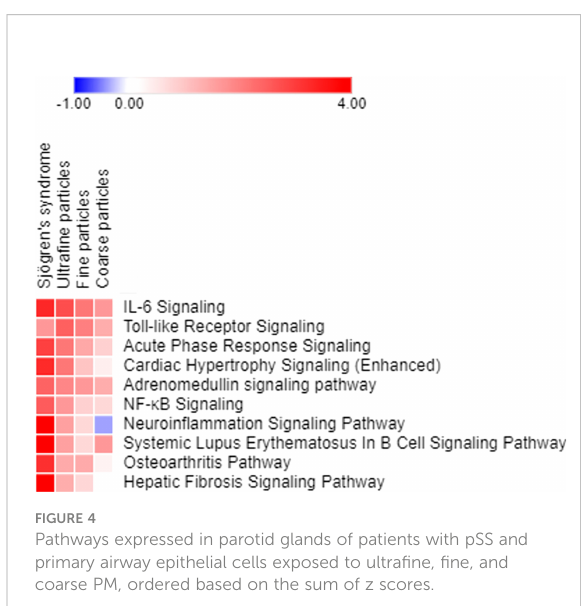
(Figure 4), which was in line with signi fi cant fi ndings in the cohort study on small gaseous molecules.